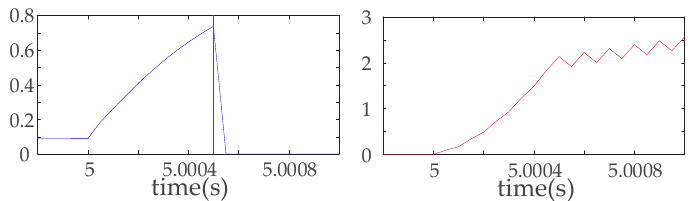
Figure 9. External pole-to-pole fault for Voltage Source Converter (VSC) protection.